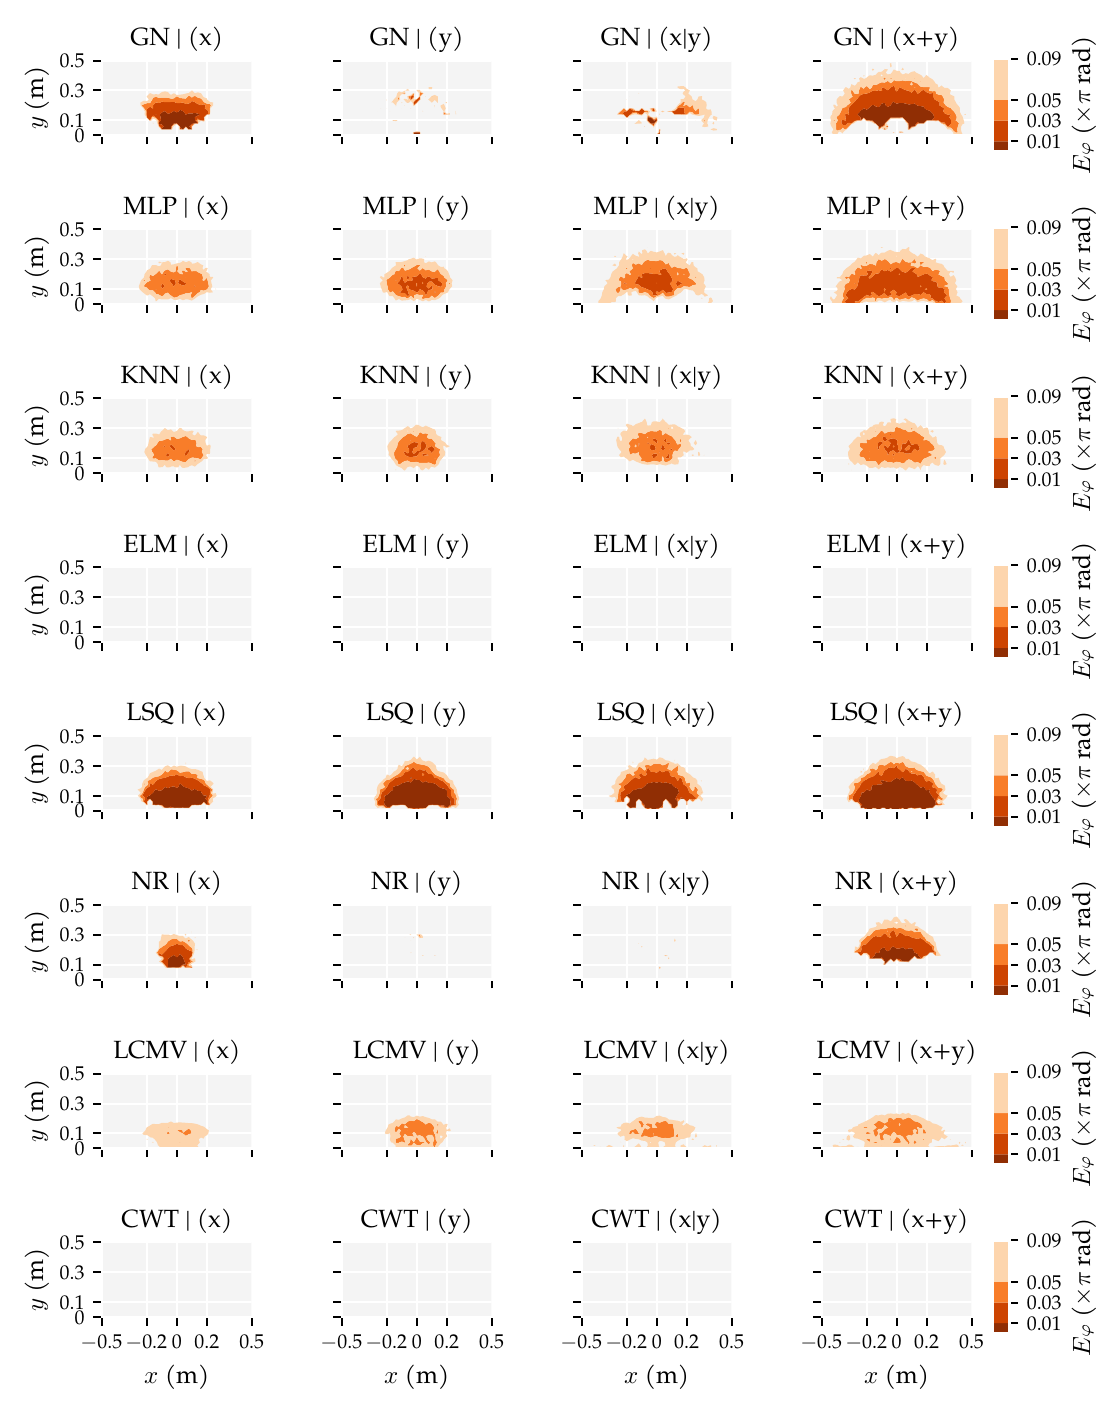
Figure A9. Spatial contours of the median movement direction error (Equation (5)) for each localisation algorithm in all conditions of Analysis Method 2. This analysis varied the sensitivity axes of the sensors: (x + y) measured both velocity components at all sensors, (x|y) alternated measuring v x and v y for subsequent sensors, (x) measured only v x at all sensors, (y) measured only v y at all sensors. The D s = 0.01 training and optimisation set and σ = 1.0 × 10 − 5 ms − 1 noise level were used. The median movement direction error was computed in 2 × 2 cm 2 cells. The sensors were equidistantly placed between x = ± 0.2